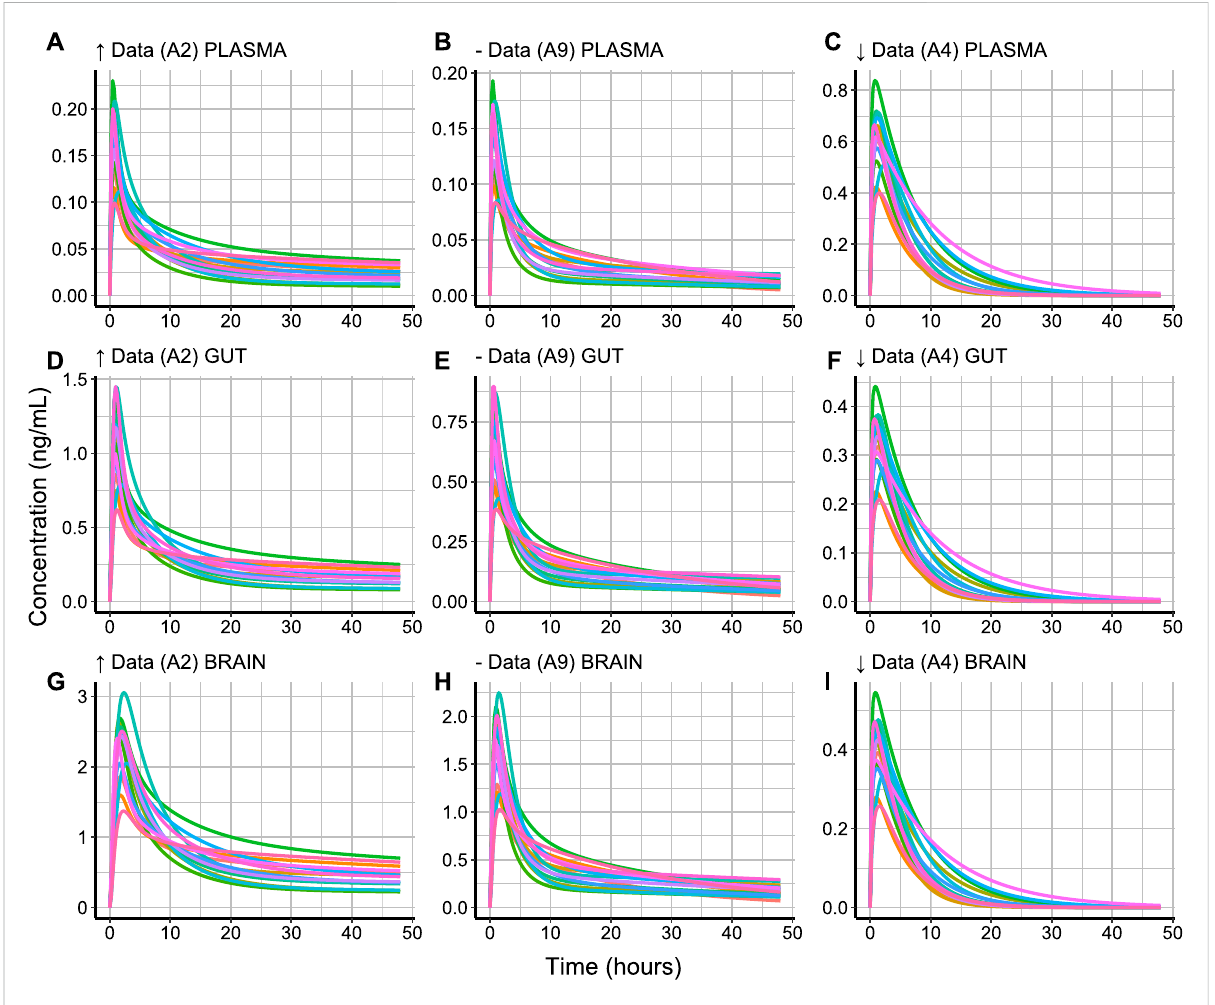
FIGURE 4 Simulated concentration-time pro fi les ( ng/mL ) in 15 healthy subjects for 48 h in (A – C) plasma, (D – F) gut and (G – I) brain for compounds with high ( ↑ Data, A2), medium ( − Data, A9), and low ( ↓ Data, A4) data availability. The different subject pro fi les are